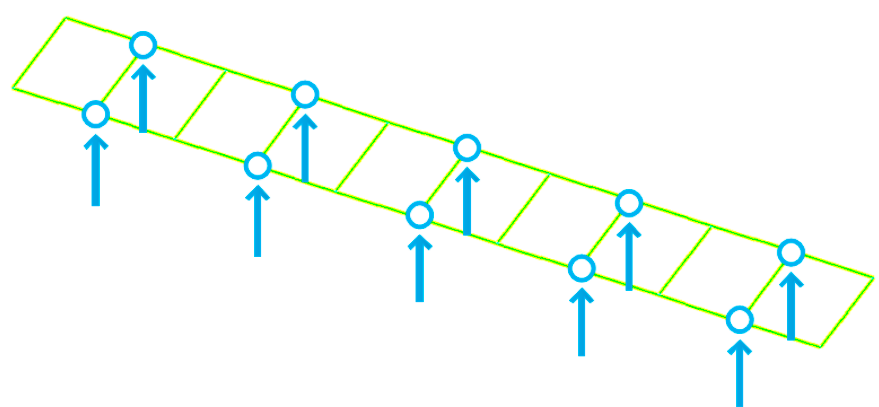
Figure 2. Configuration of ten measurement points on the bridge deck.